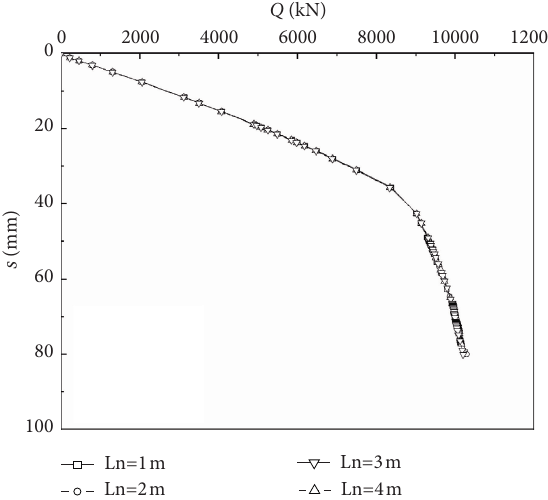
Figure 14: Influence of the spacing of the neighboring nodules on bearing